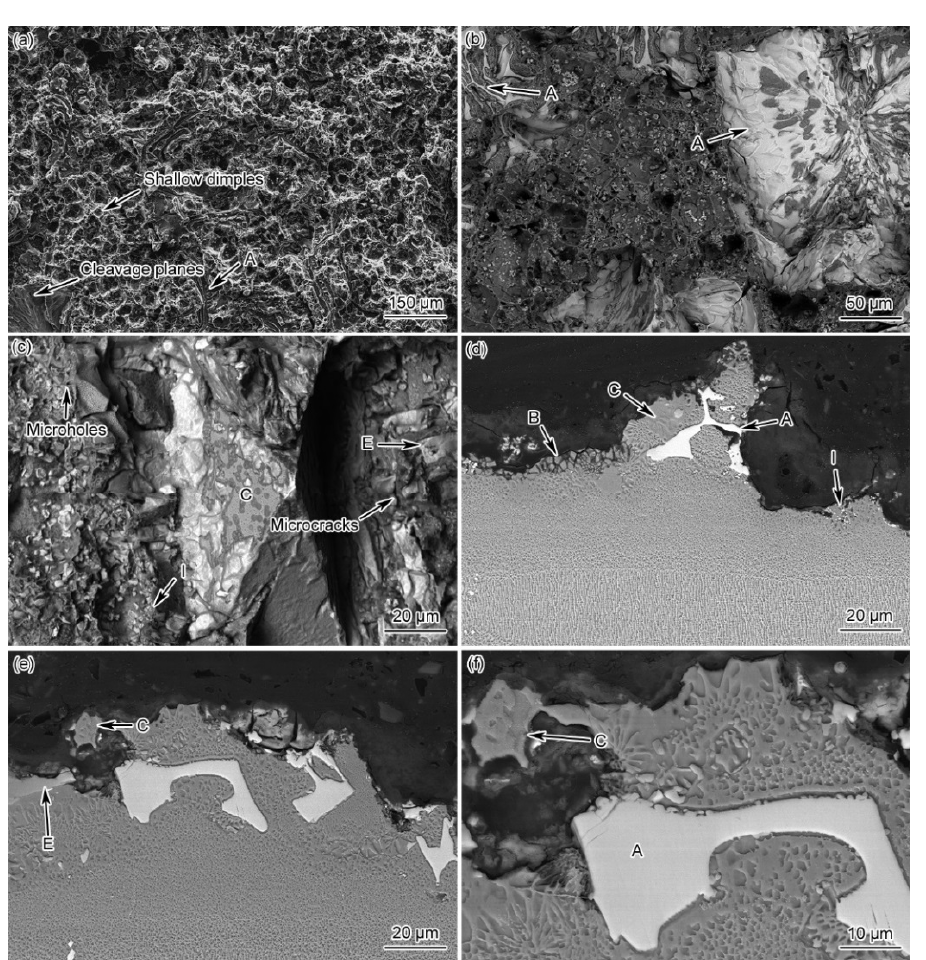
Figure 12. The morphologies of the fractured surface and longitudinal section of the as-prepared joints (A, B, C, E, I represent Area-A-B-C-E, and -I, respectively): ( a – c ) fracture morphology and ( d – f ) longitudinal section morphologies. Table 3. EDS analysis of different phases at the fractured surfaces of the as-prepared and PBHT- processed joints.